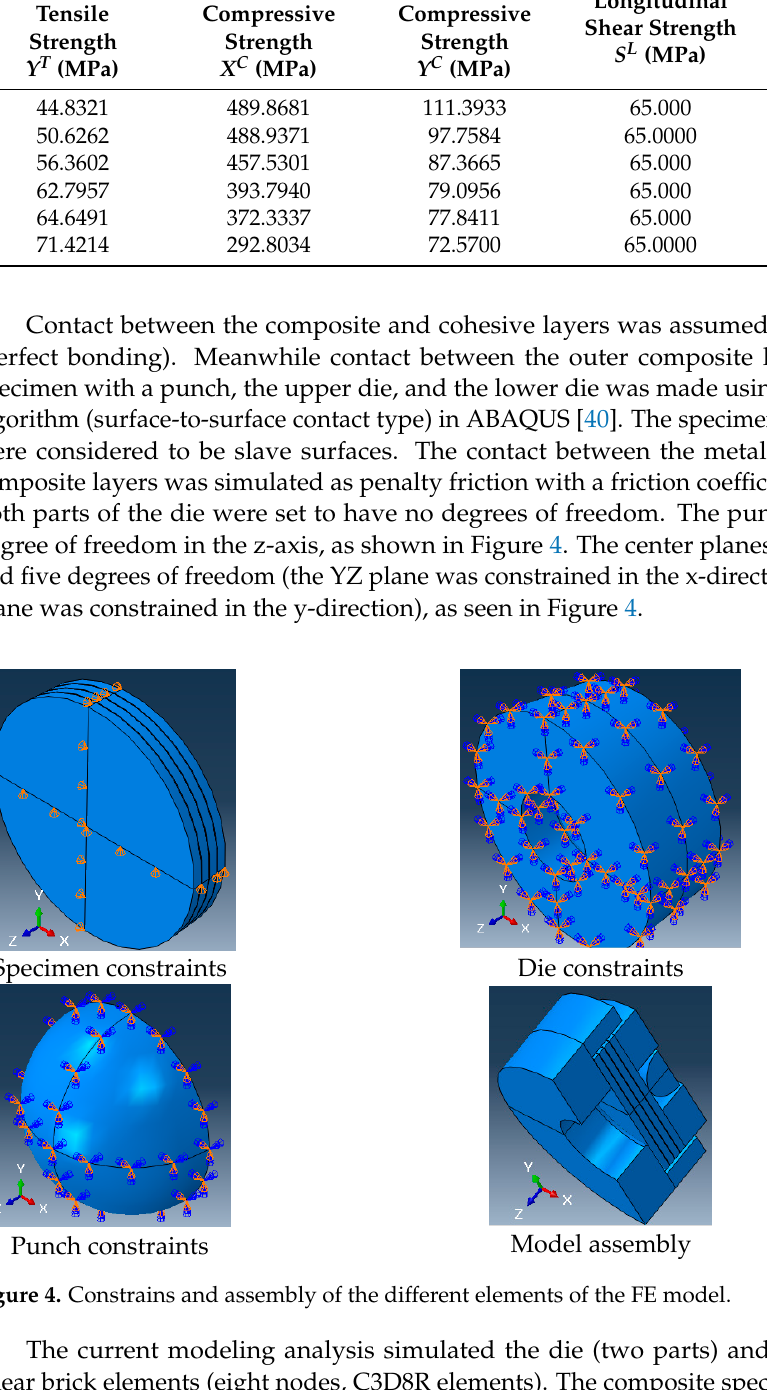
Figure 5. Mesh of the different elements of the FE model.